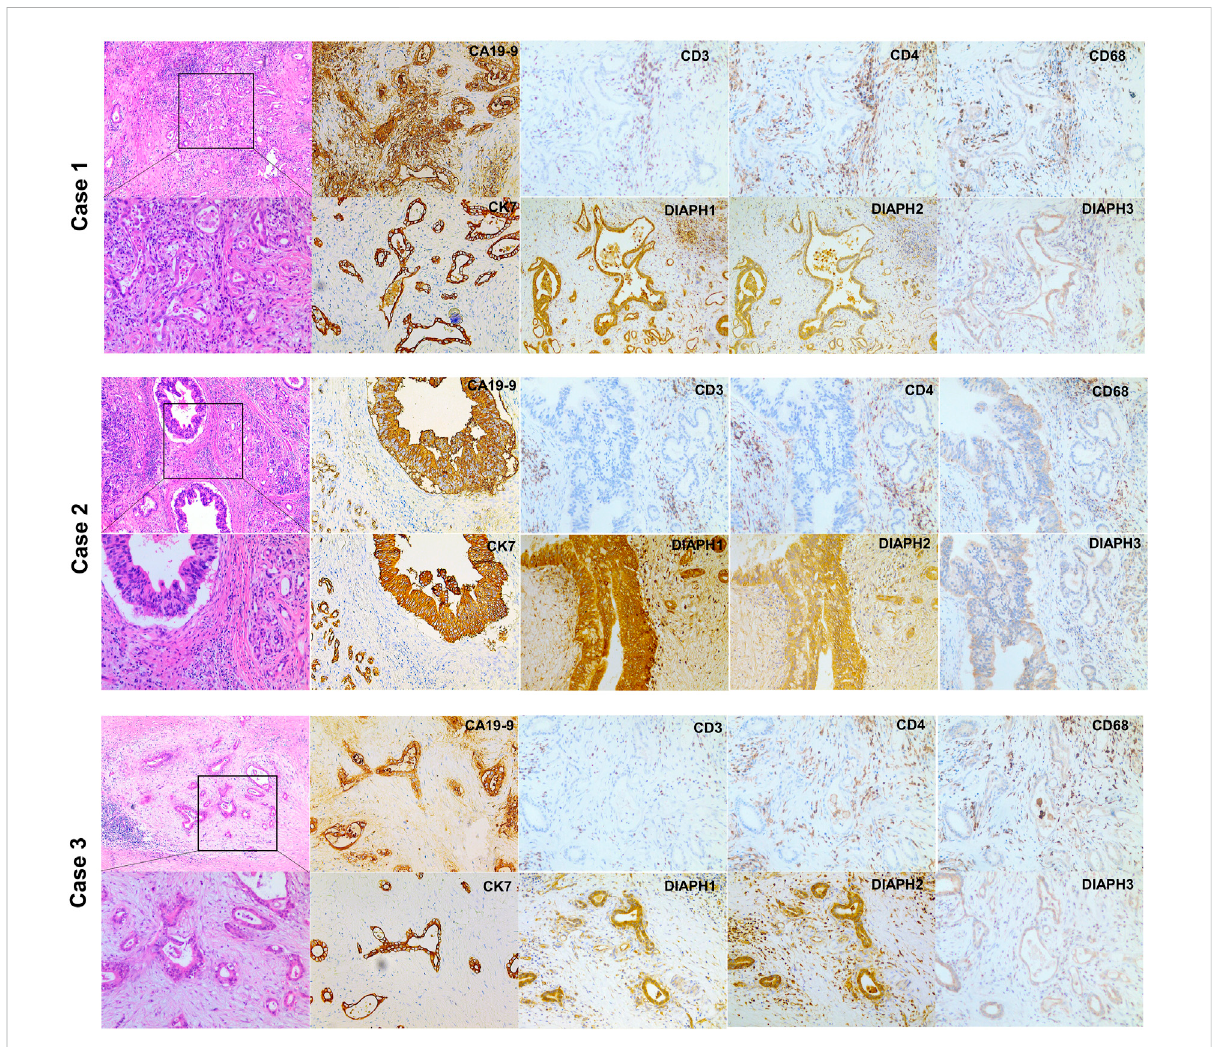
FIGURE 11 H&EandIHCstainingofhumanpancreaticductaladenocarcinoma.H&Estainingofpancreaticductaladenocarcinoma(left,×40,×100).CA19-9, CK7 and DIAPHs expression and the in fi ltration of T lymphocytes and macrophages in pancreatic tumor tissue (right,